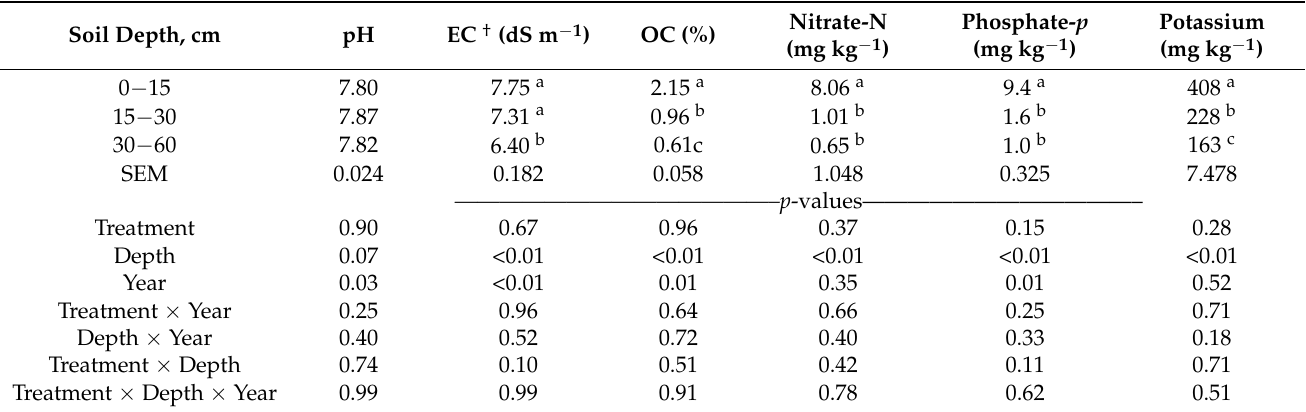
Table 3. Physicochemical properties of soil at three depths after harvest in Clavet, Saskatchewan, Canada (2019 to 2021